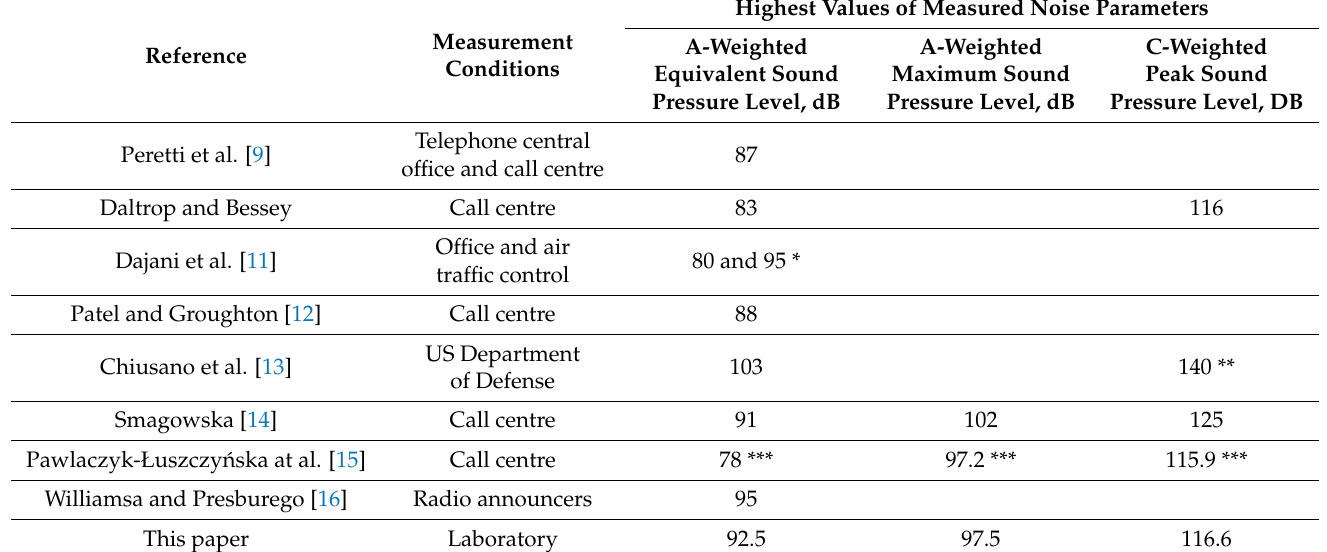
Table 5. A summary of the highest values of L Aeq , L Amax and L Cpeak determined by different measurement methods under real conditions taken from the literature and obtained in this work under laboratory